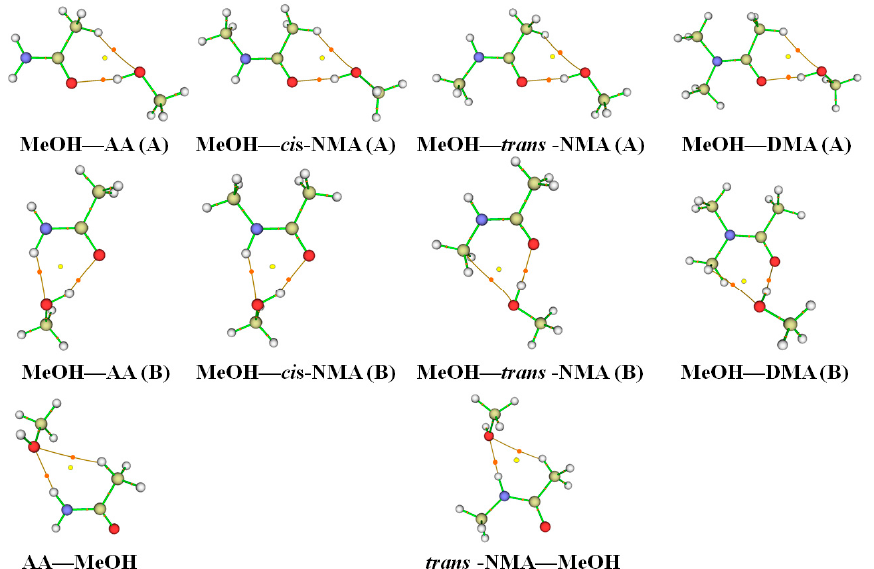
Figure 5. The Atoms in Molecules (AIM) plots of the MeOH–acetamide and acetamide–MeOH complexes obtained at the B3LYP-D3/aug-cc-pVTZ level. The bond critical points (BCPs) and ring critical points (RCPs) are presented by the ginger and yellow balls, respectively; AA: acetamide; NMA: N -methylacetamide; DMA: N , N -dimethylacetamide; MeOH: methanol.